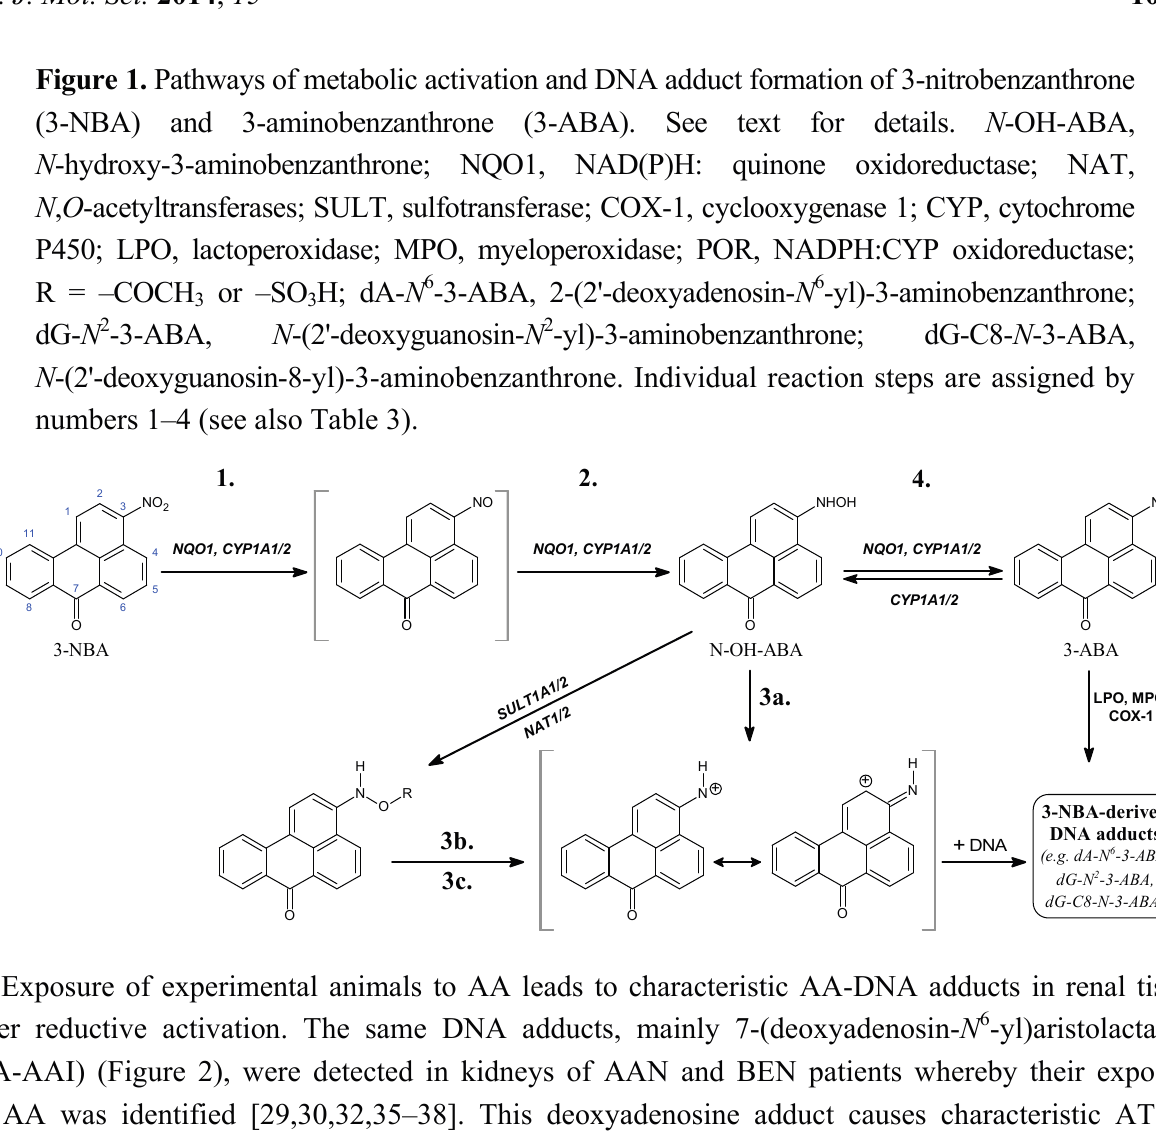
dG-N 2 -3-ABA, dG-C8-N-3-ABA)